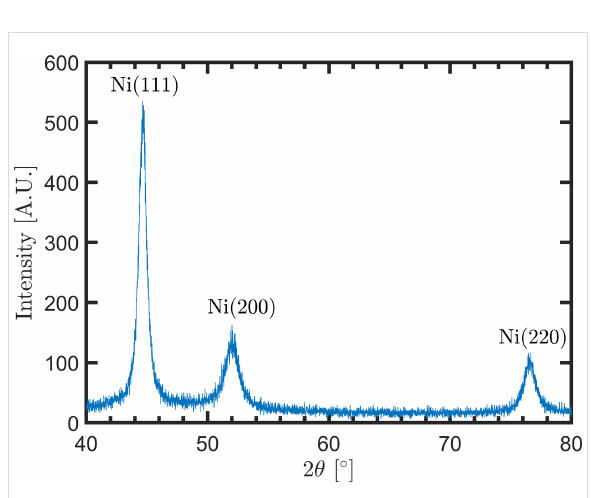
Figure 3: GiXRD pattern of the nickel film deposited by dcMS, conven- tional position, at 0.6 Pa, and 150 W power.